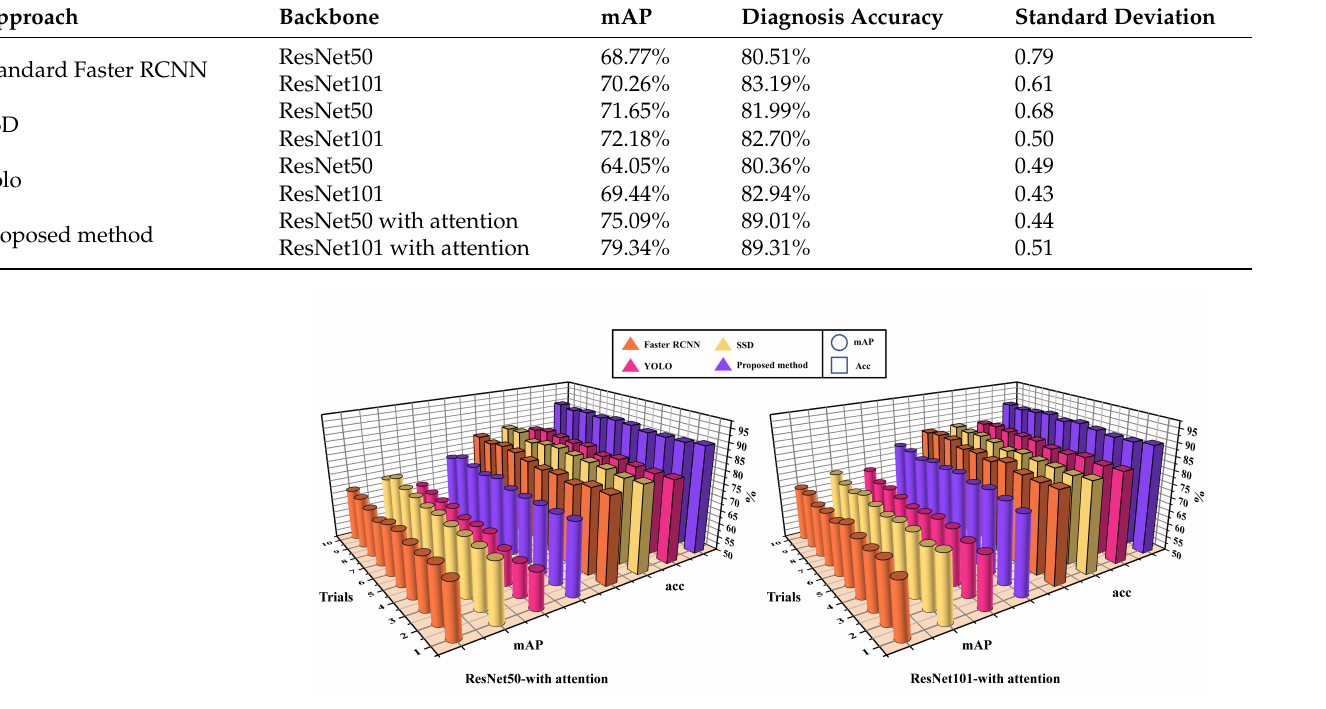
Figure 14. Comparison results of the 10 trials.